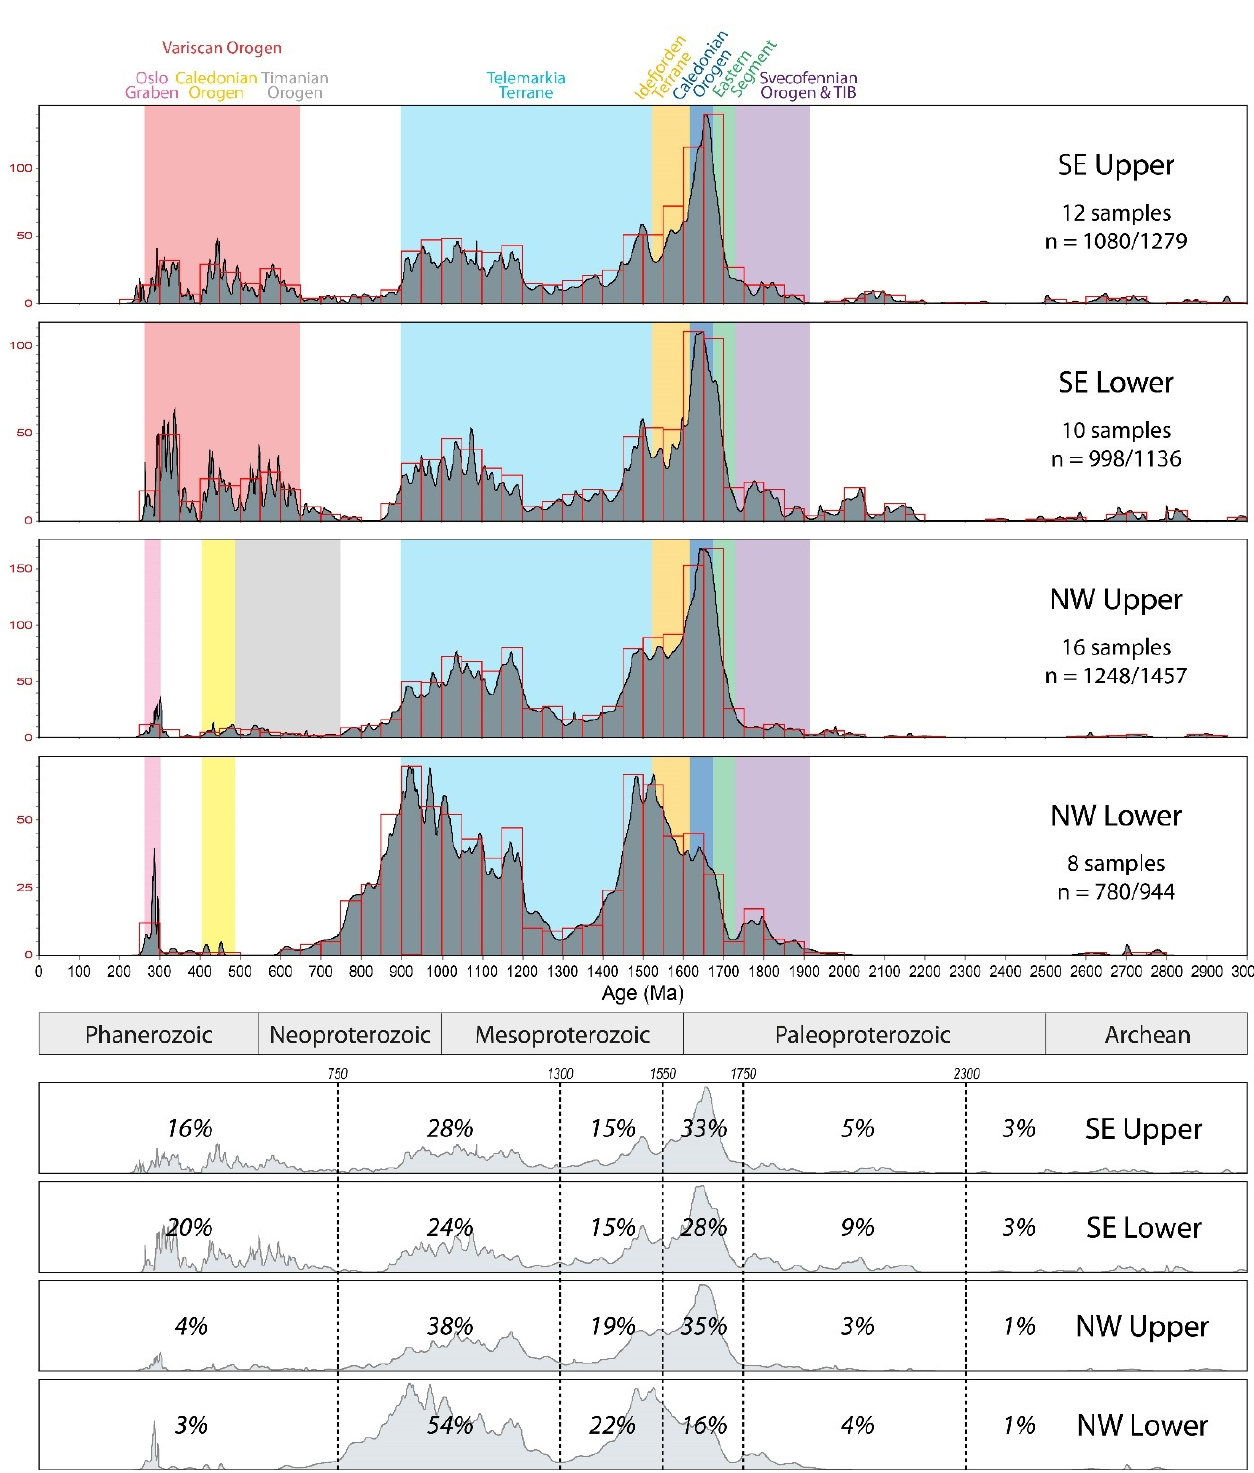
Figure 6. Zircon U-Pb age distributions with 50 Ma histograms. Samples are merged for the NW and SE parts of Gassum Formation divided into the lower and upper part. Ages with a discordance < 10% and without common lead are included. The most likely origins of the zircon age populations are visualized by colors (see Figure 2 for locations of the basement areas). The relative proportions of the number of ages within six age intervals are shown by